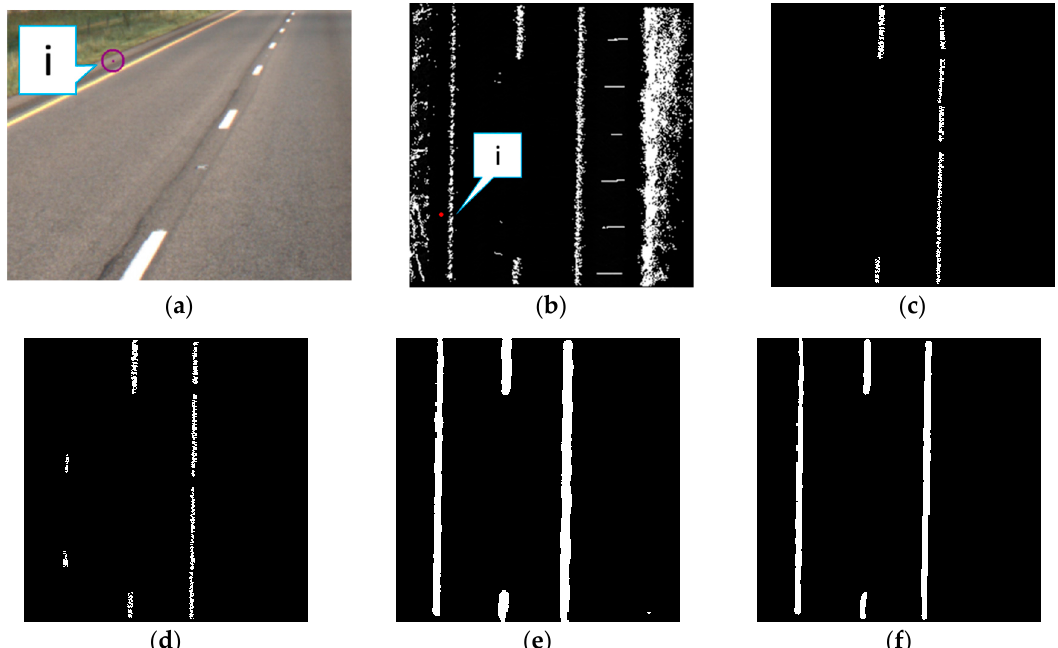
Figure 21. RGB imagery of ( a ) location i and ( b ) location ii and illustrations of ( c ) original intensity images, and images with predicted lane markings from ( d ) U-net model 1 and ( e ) U-net model 2 in dataset 2.